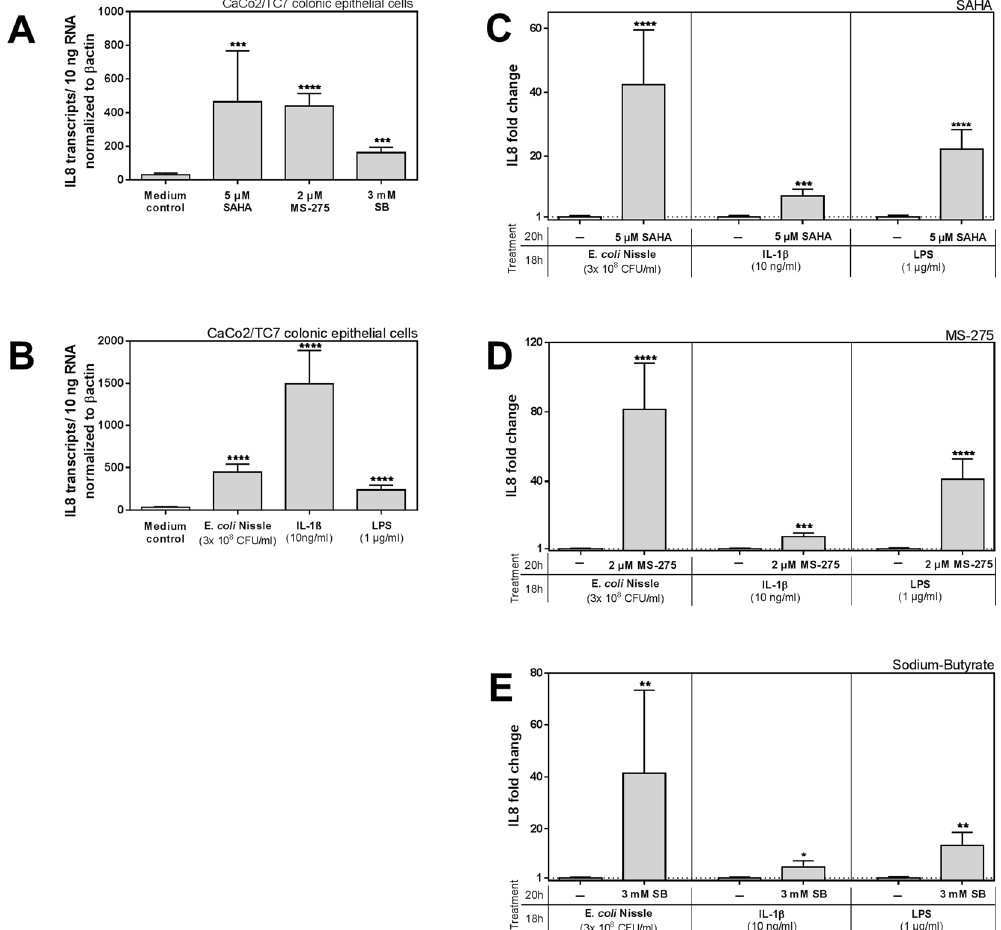
Figure 2. Effect of histone deacetylase (HDAC) inhibition on Interleukin 8 (IL8) expression in CaCo-2/TC7 cells. Expression of IL8 mRNA after ( A ) treatment with HDAC inhibitors SAHA (5 µ M), MS-275 (2 µ M) or SB (3 mM) each for 20 hrs or ( B ) with the probiotic strain E. coli Nissle 1917 (3 × 10 8 CFU/ml), IL1 β (10 ng/ml) or LPS (1 µ g/ml) each for 18 hrs. Shown are relative copy numbers of hBD2 per 10 ng total RNA normalized to β actin expression. ( C – E ) Shows the fold change in IL8 induction compared to each stimulation alone when co-treated with either SAHA (5 µ M) ( C ) MS-275 (2 µ M) ( D ) or SB (3 mM) ( E ). Inhibitor treatment started 2 hrs prior to the stimulations, which took then place in parallel to HDAC inhibition for another 18 hrs. Shown are results of at least three independent experiments carried out in biological triplicates. * p < 0.05, ** p < 0.01, *** p < 0.001, **** p < 0.0001 evaluated by Mann-Whitney u